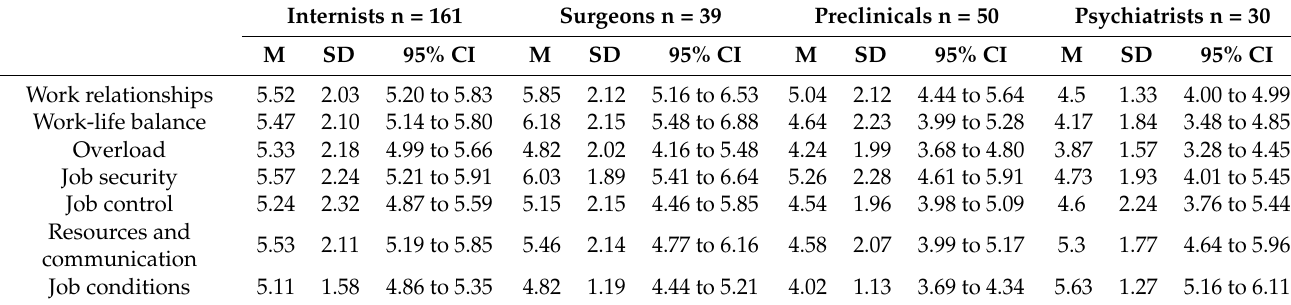
Table 2. Mean values of variables related to stress within different medical specialties.